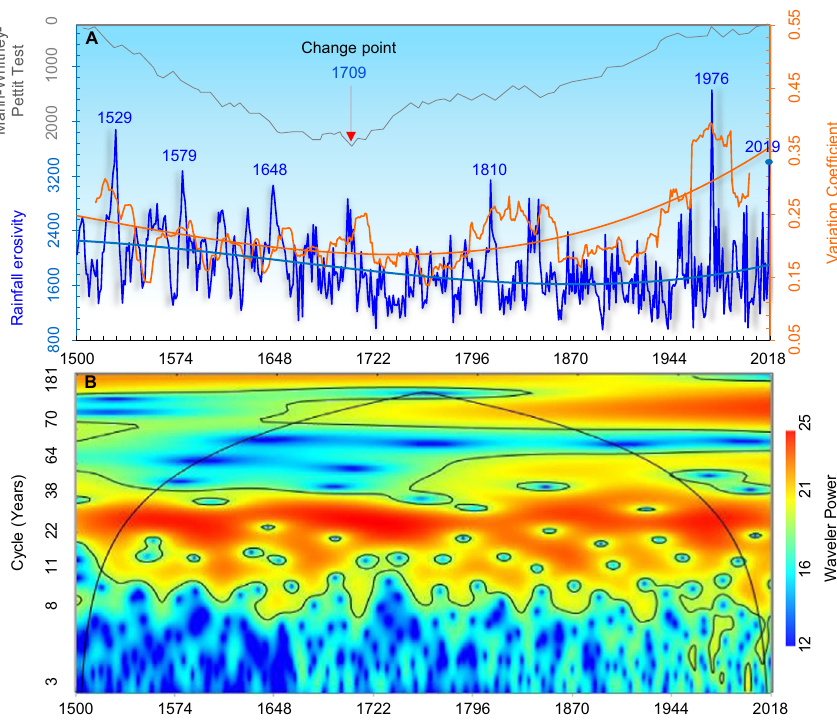
Fig. 5 Overview of several rainfall erosivity patterns over PRL along the period 1500 – 2019 CE. ( A ) Timeline evolution of rainfall erosivity reconstructed by Eq. (1) (blue thin curve with signed dates when the 98th percentile is exceeded), and with its 3 rd order polynomial regression (blue bold line). Mann – Whitney – Pettit 76 statistic (grey curve) with change-point in the year 1709. Variation coef fi cient running upon 31-year running window (orange thin curve) with related 3 rd order polynomial trend (orange bold curve) ( B ) Wavelet power spectrum with Morlet basis function for the reconstructed rainfall erosivity; bounded colours identify the 0.10 signi fi cance level areas; the bell-shaped, black contour marks the limit between the reliable region and the region above the contour where the edge effects occur (arranged from Hammer et al. 124